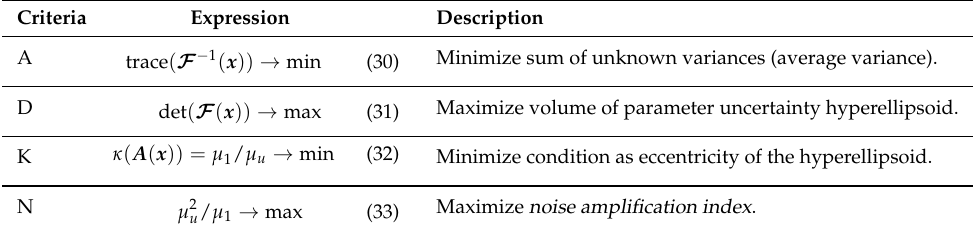
Table 4. Observability indicies and optimization criteria